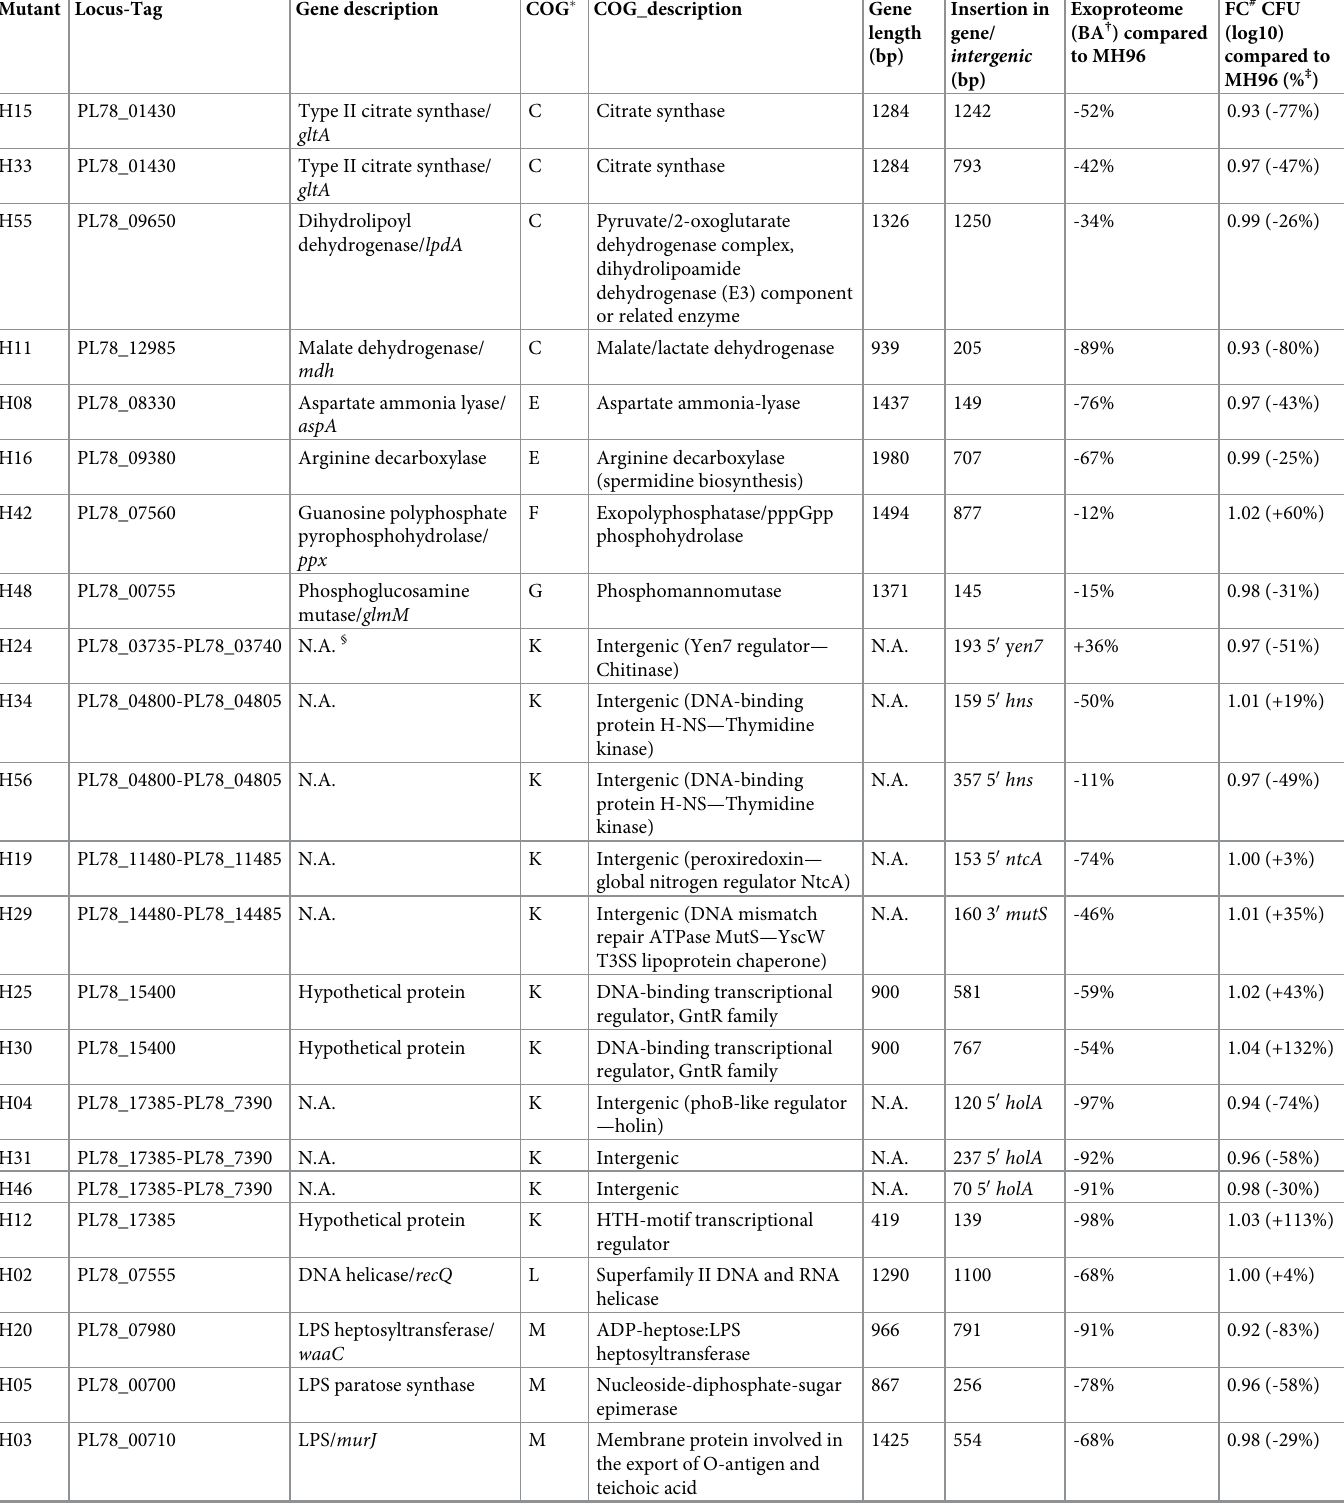
Table 1. MH96 HESA transposon mutants generated in this study, grouped by COG category. Mutant